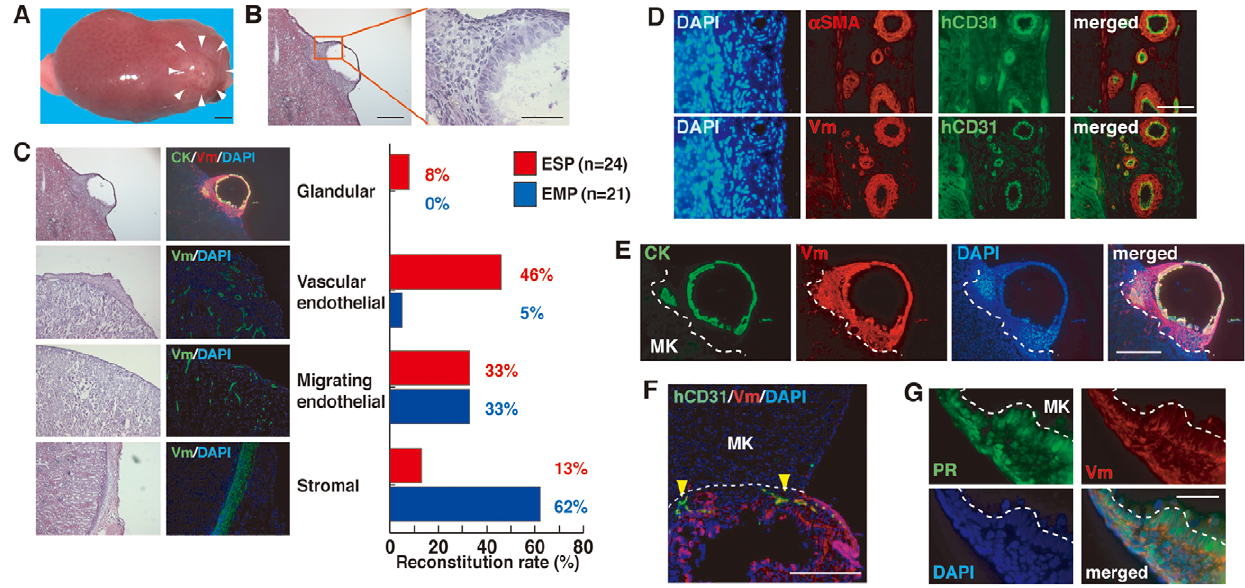
Figure 2. Recreation of the human endometrium and its components from ESP cells in immunodeficient mice. ( A ) The macroscopic appearance of an ESP-initiated lesion (surrounded by white arrowheads) in the kidney of a NOD/SCID/ c cnull (NOG) mouse treated with E 2 pellets for 10 weeks. Bar, 1 mm. ( B ) H&E-stained section of the same lesion indicated in ( A ). A small box marks a region shown at a higher magnification in the adjacent panel as indicated. Bars, 500 m m (left) and 100 m m (right). ( C ) H&E-stained and immunofluorescence images of ESP- or EMP-initiated lesions co-stained with DAPI and antibodies against CK and Vm where various endometrial cell components were formed. The right table shows the number and frequency of the ESP- or EMP- initiated mice which predominantly possessed human endometrium with glandular structures, vessel-like structures consisting of endothelial cells, migrating endothelial cells, or stromal cell components. Bars, 500 m m. ( D ) Immunofluorescence images of serial sections of the ESP-initiated lesion co-stained with DAPI and antibodies against a SMA and hCD31. Note that ESP-initiated vessel-like structures positive for hCD31 and Vm were surrounded by muscle-like layers positive for a SMA and Vm. Bars, 100 m m. ( E ) Immunofluorescence images of the same lesion as ( A ) co-stained with DAPI and antibodies against CK and vimentin (Vm). Bars, 500 m m. The borders between the reconstituted tissue and the mouse kidney (MK) are indicated by the dotted lines. ( F ) Immunofluorescence images of the ESP-initiated lesion co-stained with DAPI and antibodies against human CD31 (hCD31) and Vm in NOG mice. Yellow arrowheads indicate hCD31-positive cells. Bars, 200 m m. ( G ) Immunofluorescence images of the ESP-initiated lesion co-stained with DAPI and antibodies against PR and Vm. Bars, 50 m m.